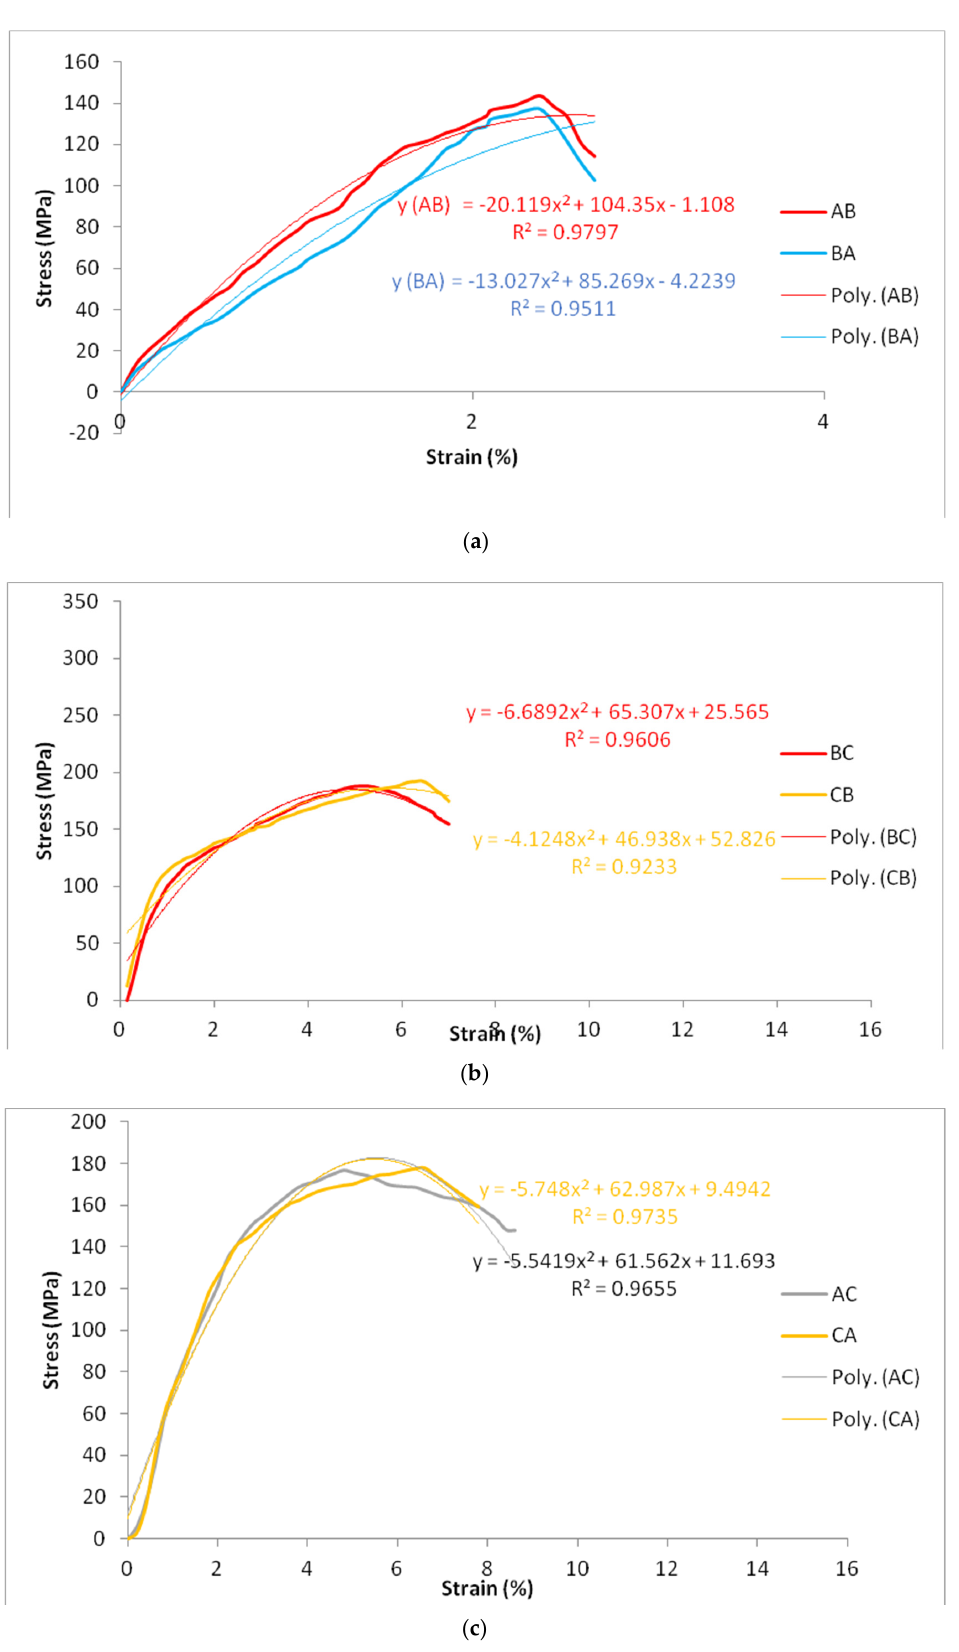
Figure 5. Stress–strain curve of the dissimilar joint of FSW ( a ) AA6061 and AZ31B and AZ31 and AA6061, ( b ) AZ31B and AZ91 and AZ91 and AZ31B, ( c ) AA6061 and AZ91 and AZ91 and AA6061.